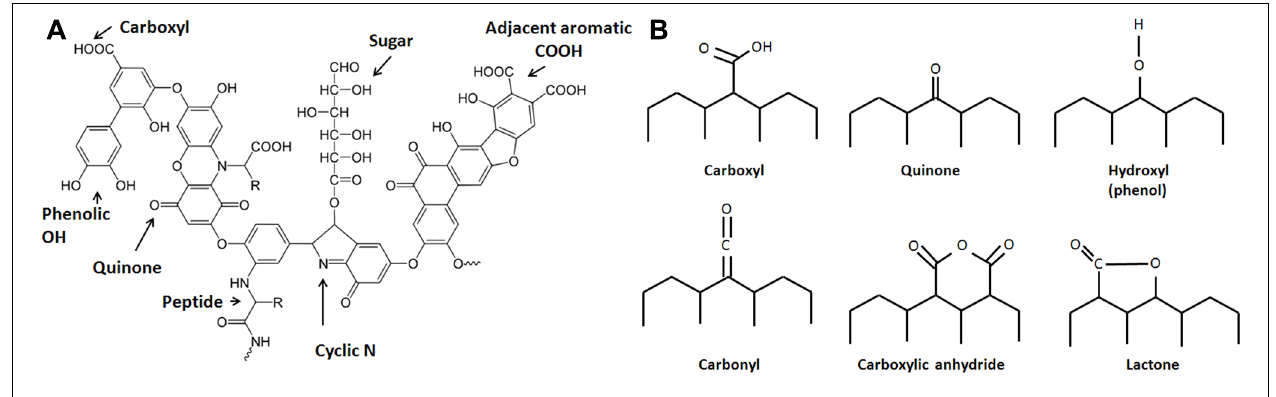
expected to be similar to those on biochar.These groups are bonded to aromatic rings (adapted fromYang,